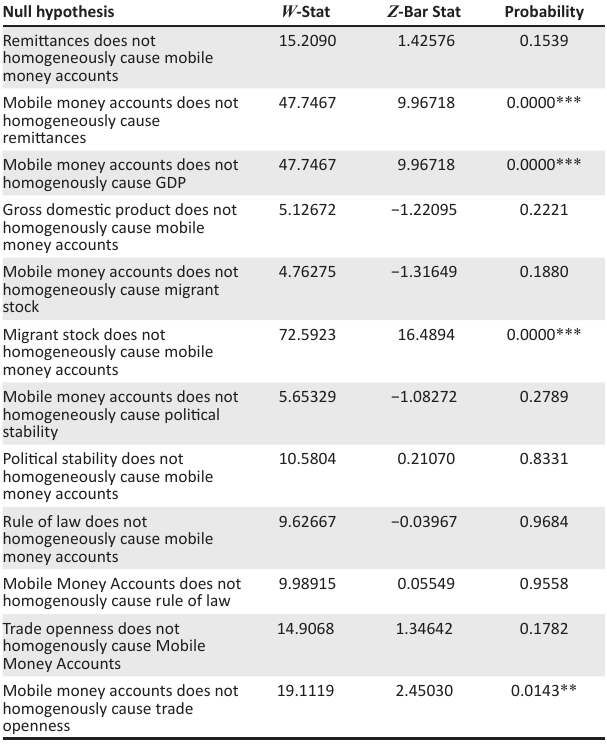
TABLE 7: Dumitrescu Hurlin Panel Granger causality